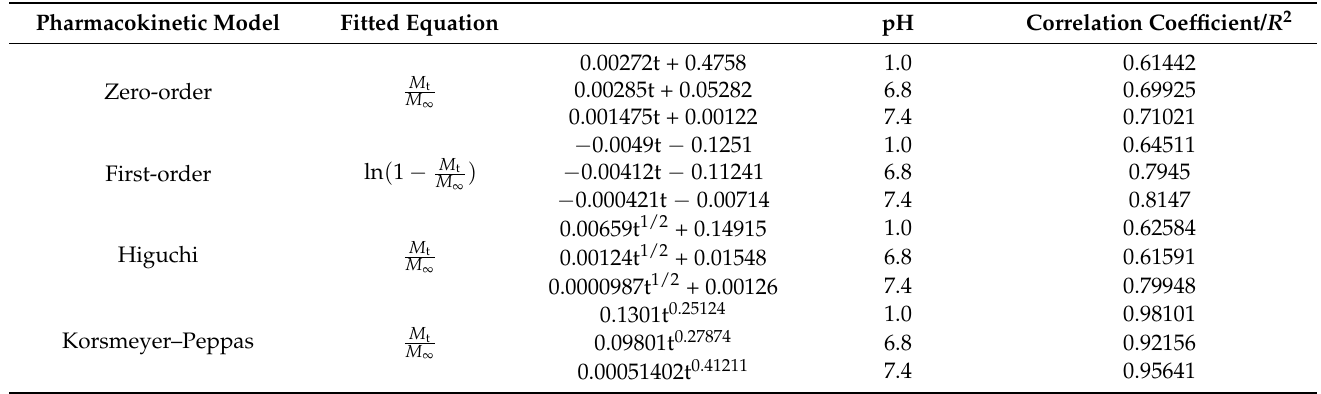
Table 3. Fitting of Gen-NH 2 -MCM-41@SA nanoparticle drug release model under different pH conditions. Pharmacokinetic Model Fitted